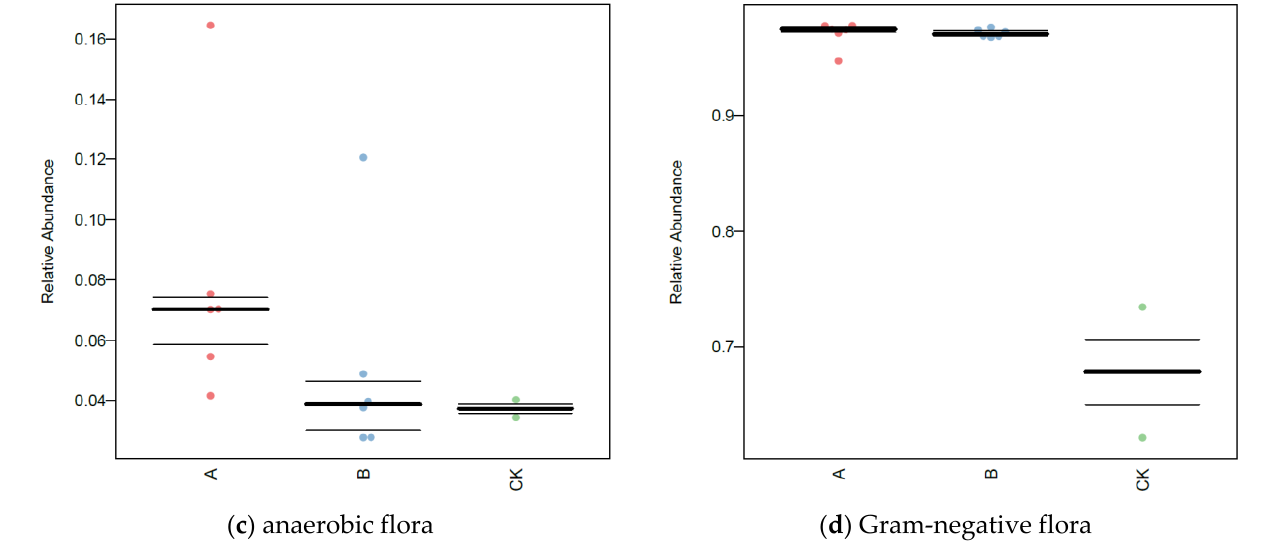
Figure 9. Phenotypes of microbiome samples based on BugBase analysis under different treatment conditions (horizontal axis is group name and vertical axis is relative abundance; group A represents each experimental group on the 56th day of the experiment and group B represents the 84th day of the experiment).